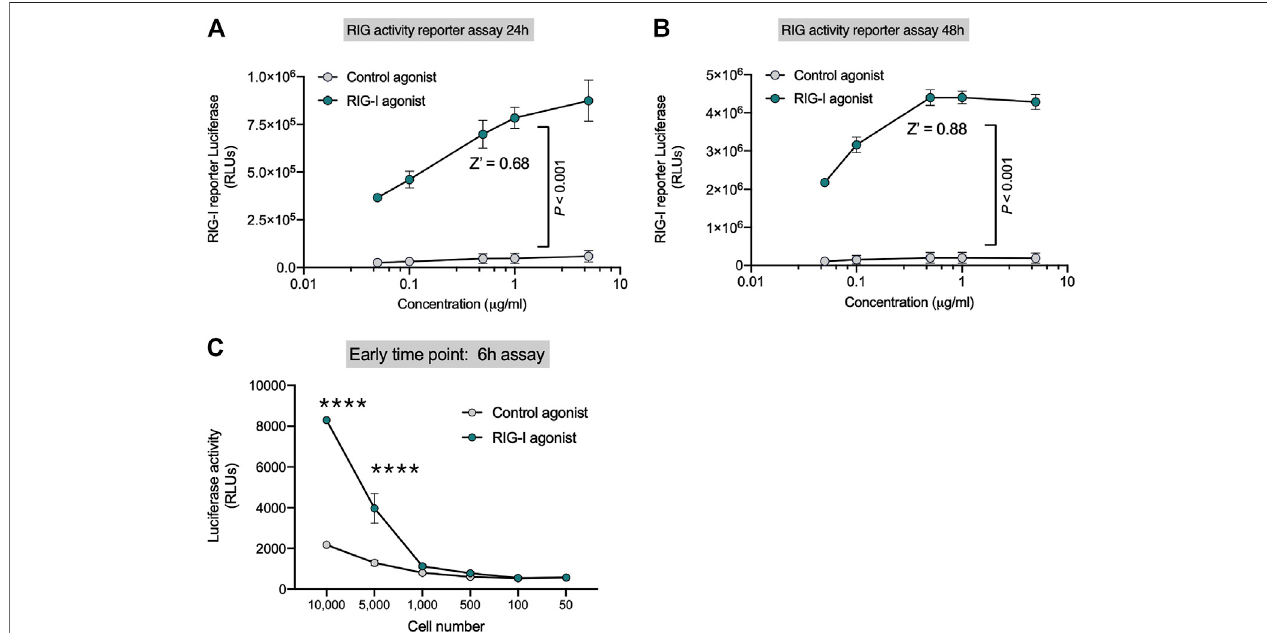
FIGURE 1 | Sensitive Reporter Assay for measuring RIG-I activity. HEK293 RIG-I cells were seeded onto 96-well plates and treated with the indicated concentrationsofacontrolagonistorRIG-Iagonist.Luciferaseactivitywasmeasured insupernatantsaspermanufacturer ’ srecommendationsat (A) 24 hand (B) 48 h. (C) Sensitivity of the RIG-I activation was evaluated with different cell numbers as indicated at an early time point – 6 h post treatment, with a control agonist or the RIG-I agonist (0.3 μ g/ml). p value from a two-way ANOVA with post-hoc Sidak ’ s correction or unpaired two-tailed Student ’ s t-test.